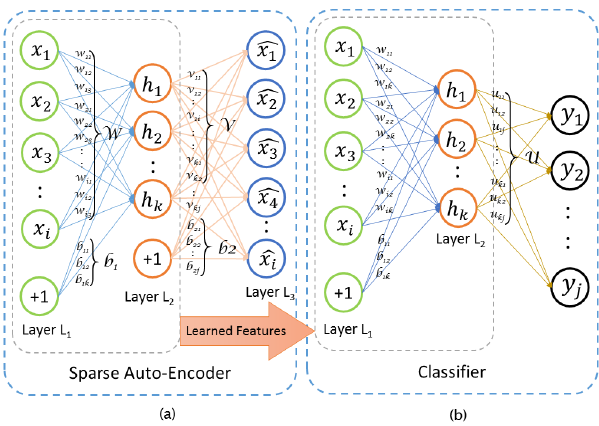
Figure 1: The two-stage process of self-taught learning: a) Unsupervised Feature Learning (UFL) on unlabeled data. b) Classification on labeled data. [18]